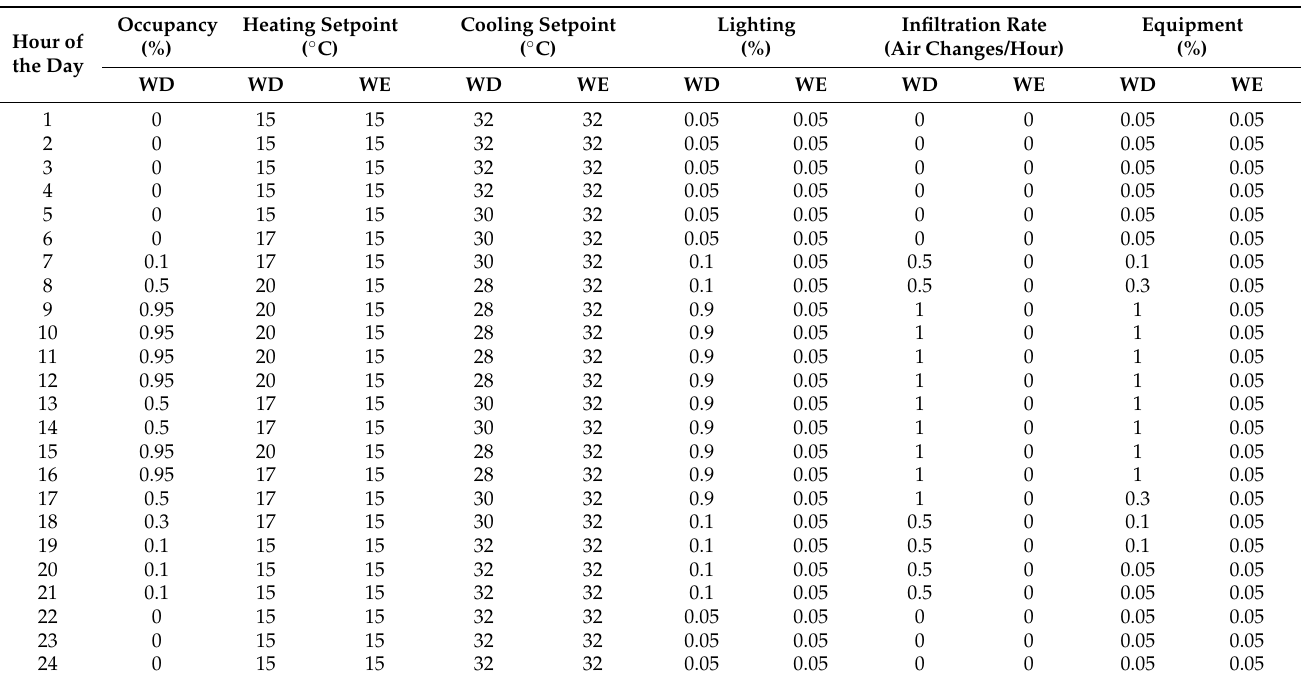
Table 4. Occupancy profile, heating-cooling system setpoints and infiltration rate schedules, the lighting system and office equipment profiles of utilization, during workdays (WD) and weekends (WE)